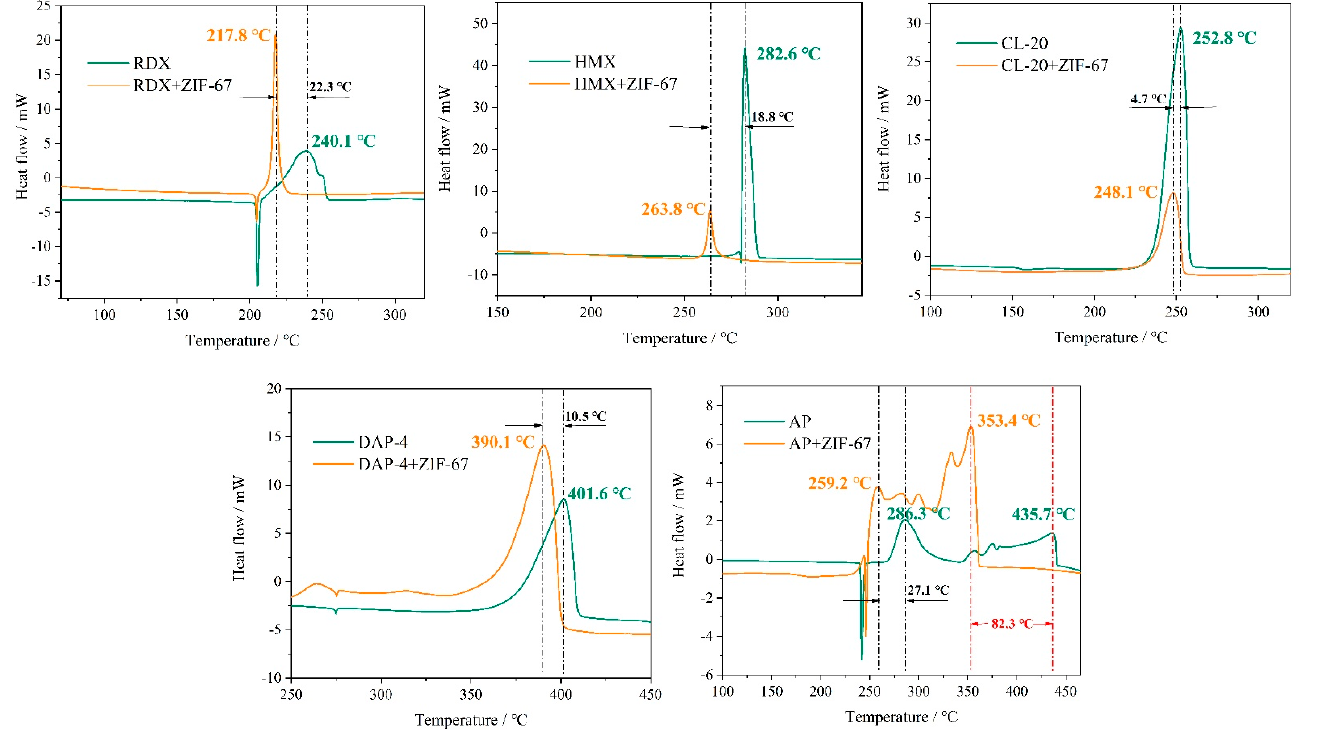
Figure 6. DSC curves for the mixtures of ZIF-67 and five different energetic materials.